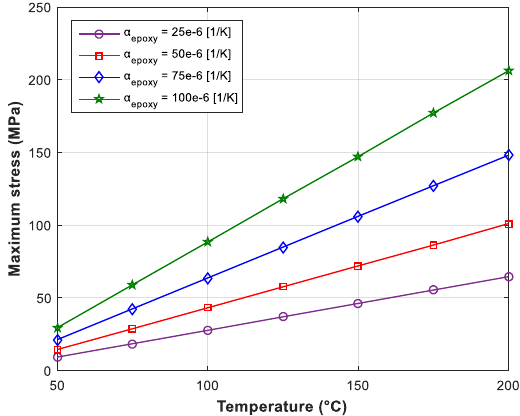
Figure 9. Maximum stress in the epoxy as a function of temperature, for different thermal expansion coefficients of epoxy.